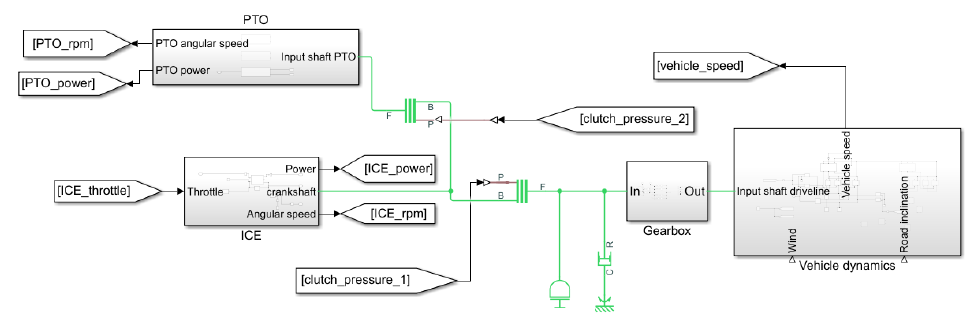
Figure 1. Simulink model architecture for the conventional